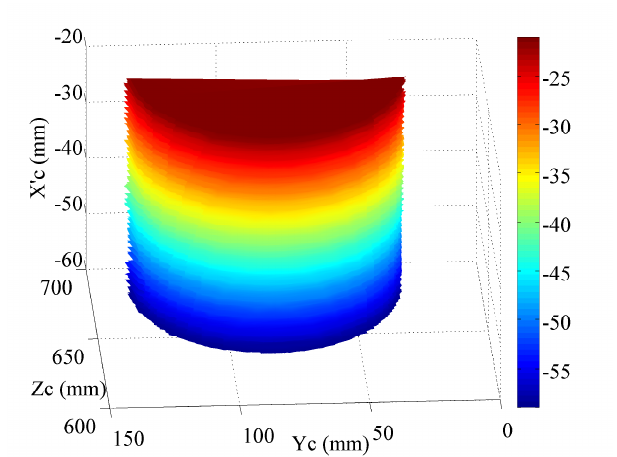
Figure 8. 3D measurement by the extended mathematical model.